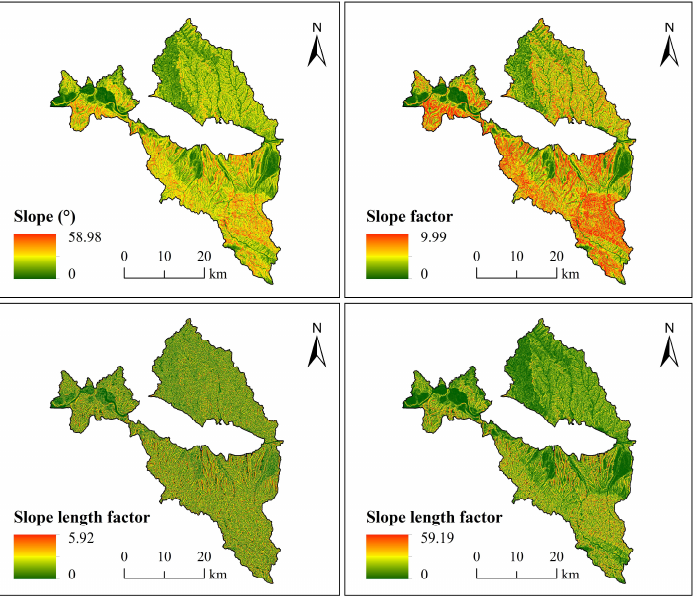
Figure 4. Spatial distribution of the gradient slope and slope length factor in the Northand South Mountains of Lanzhou.